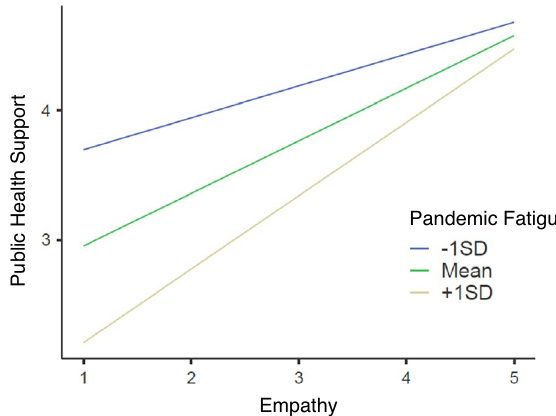
Figure 1. Estimated marginal means graph of state empathy plotted against support for public health measures, divided by low (− 1SD), average and high (+ 1SD) pandemic fatigue in Study 2. When empathy was high, there was no significance difference of pandemic fatigue on support for public health measures. However, when empathy was low, increasing pandemic fatigue decreased support for public health measures and decreasing pandemic fatigue increased support for public health